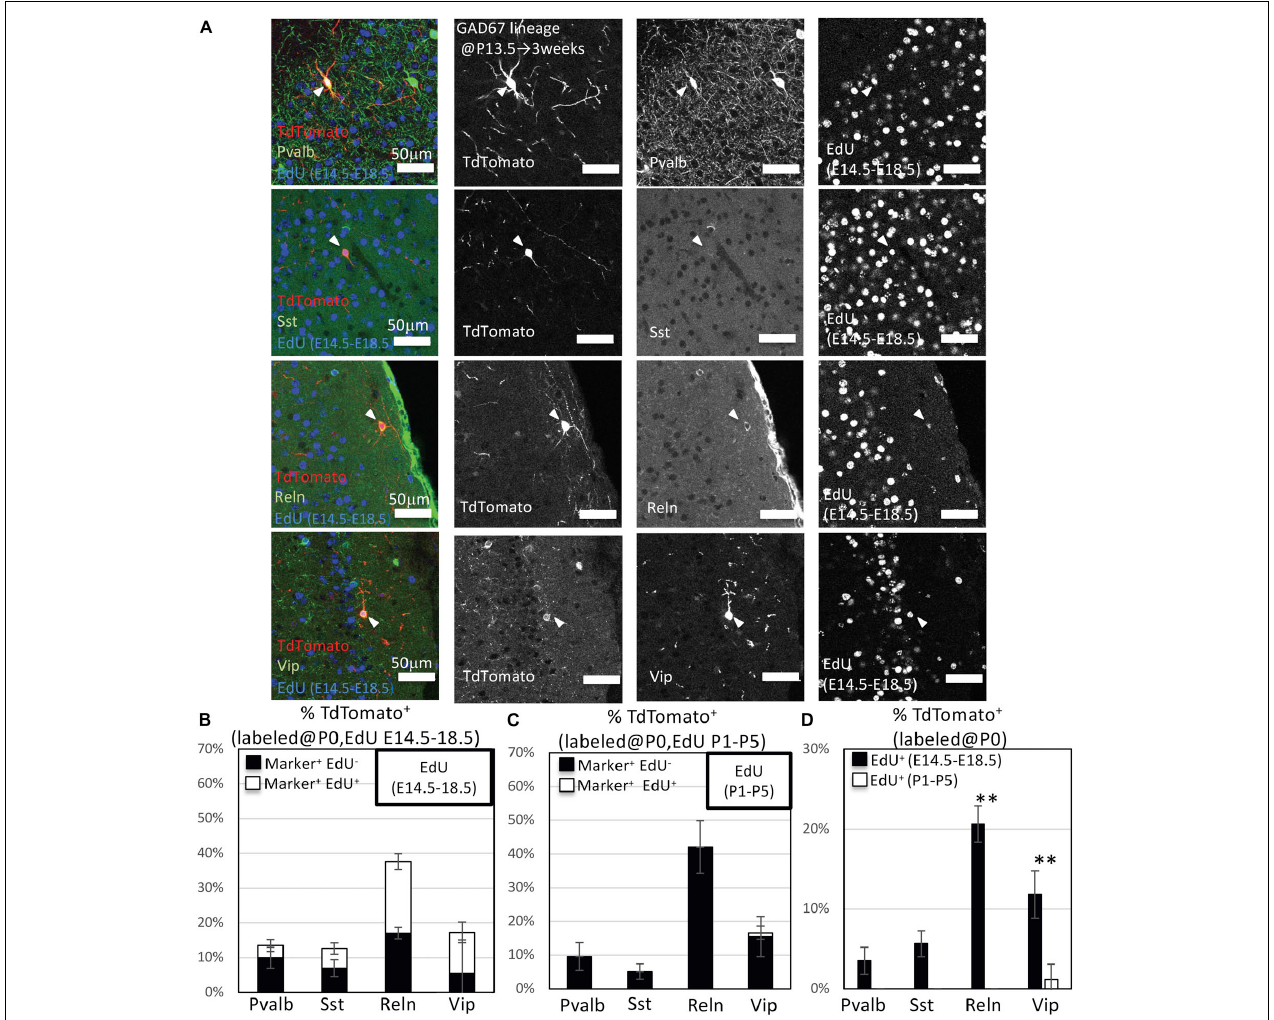
FIGURE 3 | Immunohistochemistry analysis of GAD67-lineage cells labeled at P0. (A) Triple-fluorescence immunohistochemistry of GAD67-lineage cells (red; labeled at P0) for EdU (blue; labeled E14.5–E18.5) and GABAergic (Pvalb, Sst, Reelin and Vip) neuron markers (green) from GAD67-CrePR;Ai9 mice at 3 weeks. White arrowheads indicate the triple-positive cells. Pvalb, parvalbumin; Sst, somatostatin; Reln, reelin; Vip, vasoactive intestinal peptide. (B) Percentages of TdTomato + cells labeled with EdU (E14–E18), and/or GABAergic (Pvalb, Sst, Reln, and VIP) neuron subtype markers. Black bars indicate the percentages of TdTomato + and GABAergic neuron subtype marker double-positive cells. White bars indicate the percentages of TdTomato + GABAergic neuron subtype marker and EdU + triple-positive cells. Error bars represent SDs ( n = 3 brains). (C) Percentages of TdTomato + cells labeled with EdU (P1–P5), and/or GABAergic (Parv, Sst, Reln, and Vip) neuron subtype markers. Black bars indicate the percentages of TdTomato + and GABAergic neuron subtype marker double-positive cells. White bars indicate the percentages of TdTomato + GABAergic neuron subtype marker and EdU + triple-positive cells. Error bars represent SDs ( n = 3 brains). (D) Percentages